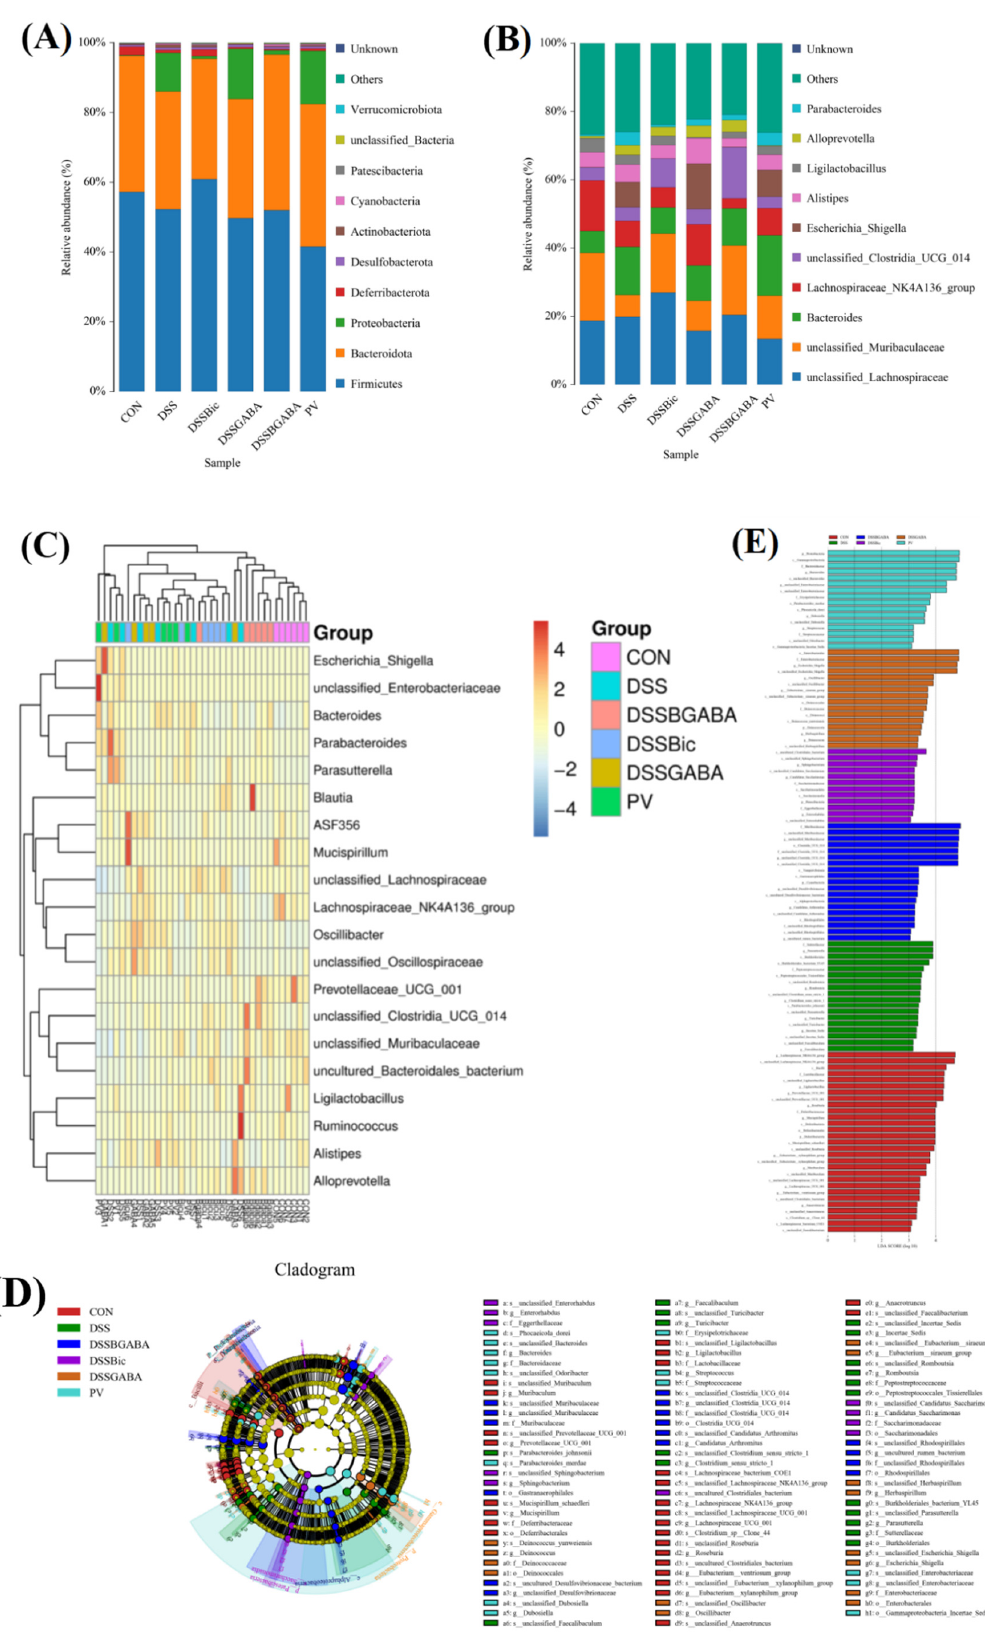
Figure 7. Analysis of the microbial composition. ( A , B ) Relative abundances of bacterial taxa at the phylum and genus levels. ( C ) Heatmap of taxa in six groups at the genus level. ( D , E ) LEfSe analysis of the dominant biomarker taxa among the six groups.